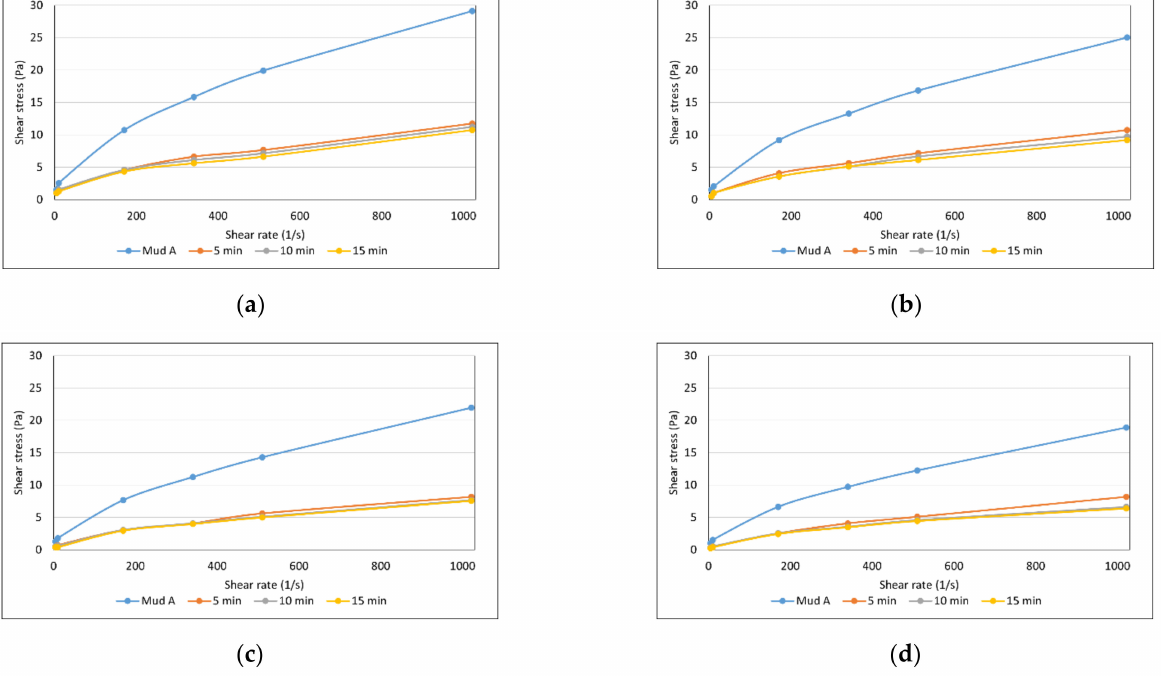
Figure 4. Flow curves of drilling mud A with the addition of 0.3% amylase: ( a ) at 20 ◦ C, ( b ) at 40 ◦ C, ( c ) at 60 ◦ C, ( d ) at 80 ◦